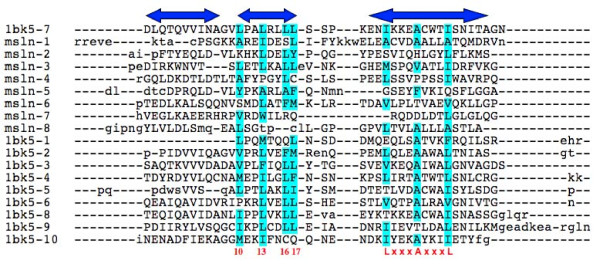
Multiple alignments of the 10 repeats of 1BK5A (1bk5-1 to 1bk5-10) and the 8 repeats of mesothelin model (msln-1 to msln-8). The three double-headed arrows at the top of the Figure indicate the boundaries of the three helical regions of the 7th repeat of 1BK5A. The first two form the outer helices and the third the inner helix. The helix boundaries of other repeats do not always agree with those of the 1BK5A 7th repeat. The residues in the 7th repeat of 1BK5A are shown in the next line in uppercase letters. The residues in all other repeats that follow are in upper or lower case letters depending on whether they align with residues of the 7th repeat of 1BK5A or not, respectively. The columns labelled 10, 13, 16 and 17 at the bottom are the key positions in the outer helix that are hydrophobic in many ARM/HEAT repeats [40]. Similarly LxxxAxxxL at the bottom indicates the conserved LEU and ALA positions in the inner helix, x being any residue. The hydrophobic residues (A, V, I, L, M, F, Y, W) in these 7 columns are highlighted.